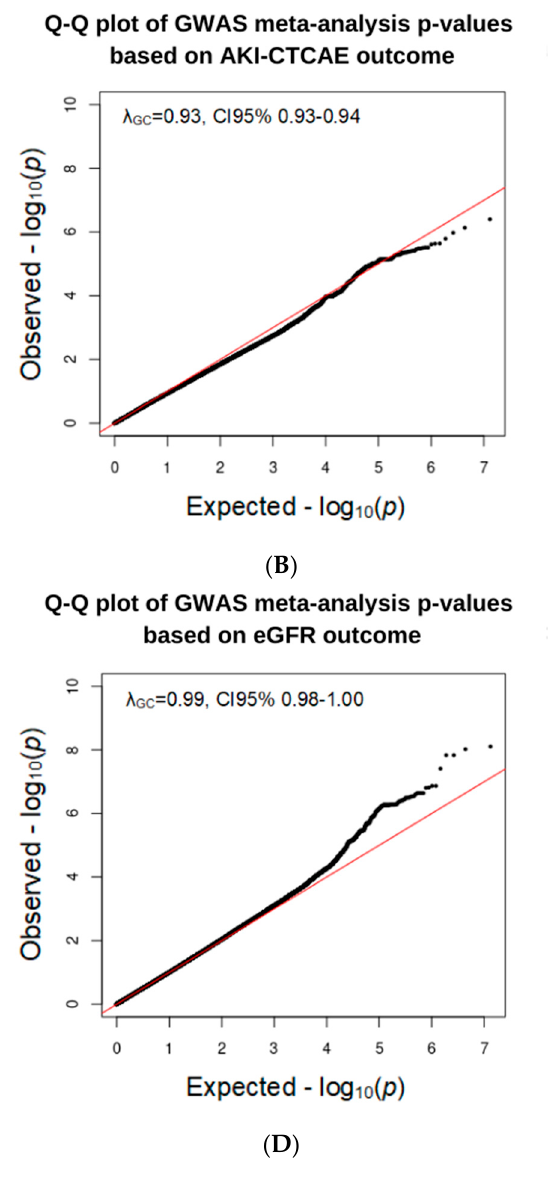
Figure 2. Genome ‐ wide meta ‐ analysis results of cisplatin ‐ induced nephrotoxicity using AKI ‐ CTCAE and eGFR phenotypes. ( A ) Manhattan plot showing logistic regression results using the AKI ‐ CTCAE phenotype; − log10 p ‐ values are plotted against the respective chromosomal position of each SNP. ( B ) A quantile–quantile (Q–Q) plot showing the distribution of p ‐ values in the GWAS using the AKI ‐ CTCAE phenotype. ( C ) Manhattan plot showing logistic regression results using the eGFR phenotype. ( D ) Q–Q plot showing the distribution of p ‐ values in the GWAS using the eGFR phenotype. Table 3. Association between BACH2 rs4388268 and cisplatin ‐ induced nephrotoxicity in the discovery cohort. Effect Size Chromosome: Functional Outcome p ‐ value Direction c (95% CI) b Location: Allele a Consequences 6:90734908:G:A